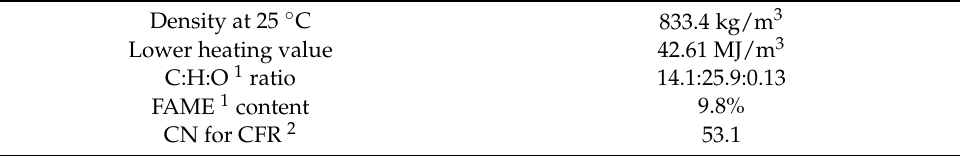
Table 3. Specification of reference fuel.